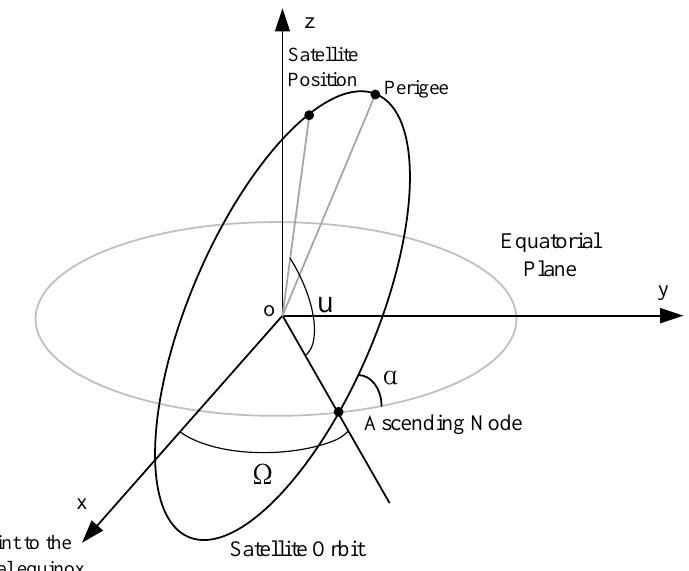
Figure 1. Schematic diagram of satellite orbit parameters.